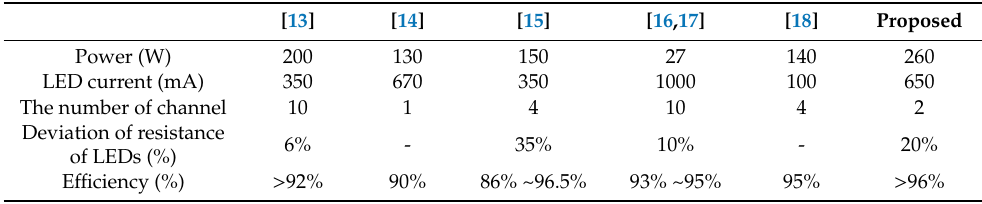
Figure 7. Experimental results. ( a ) Current according to the deviation of two LED bars’ resistance, ( b ) V Ceq according to deviation of two LED bars’ resistance ( c ) Efficiency. Table 3. Comparison of output power and efficiency using resonant converters.